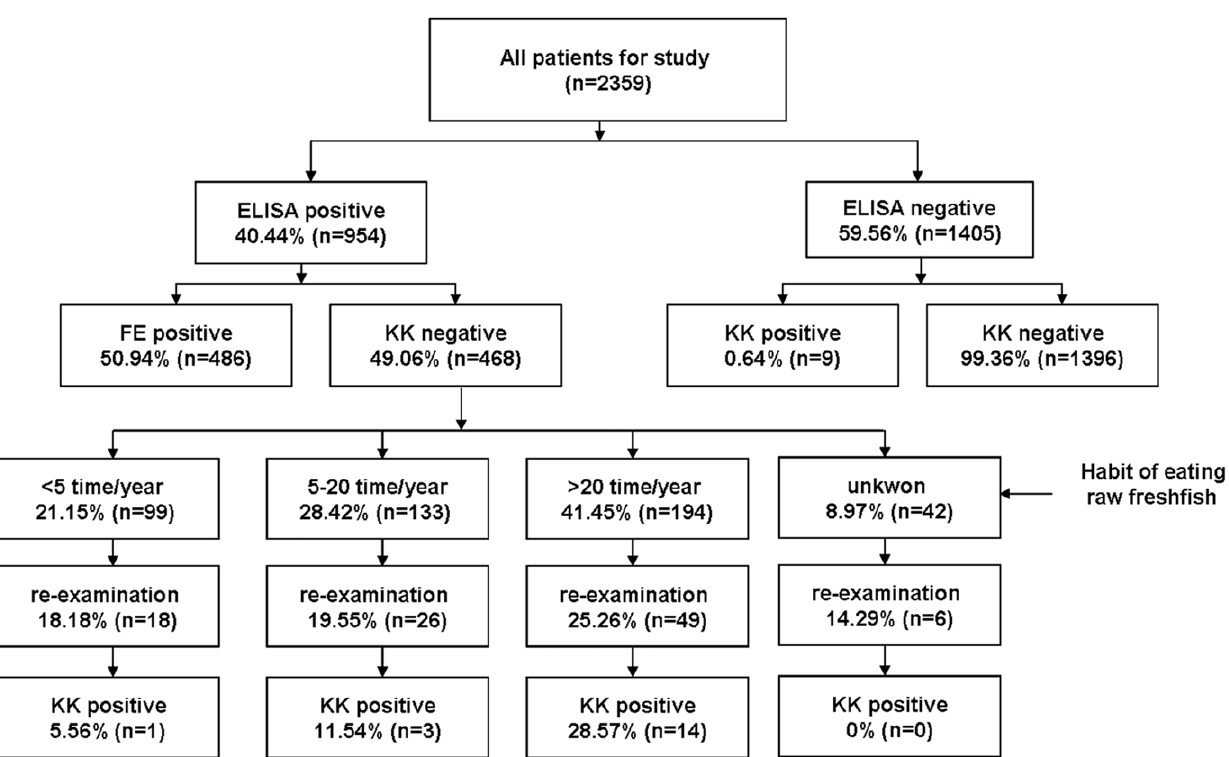
Figure 1. Flowchart for the diagnosis of 2359 patients. KK=Kato-Katz technique.